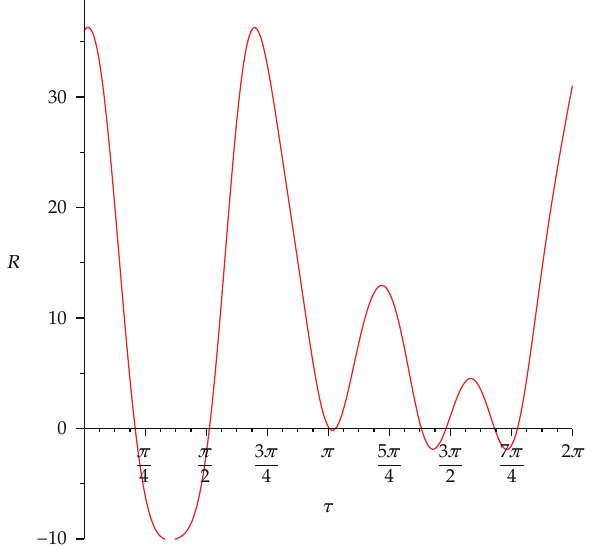
Figure 12: The evolution of the R with respect of the cosmic time τ for (cid:2) 3.22 (cid:3)